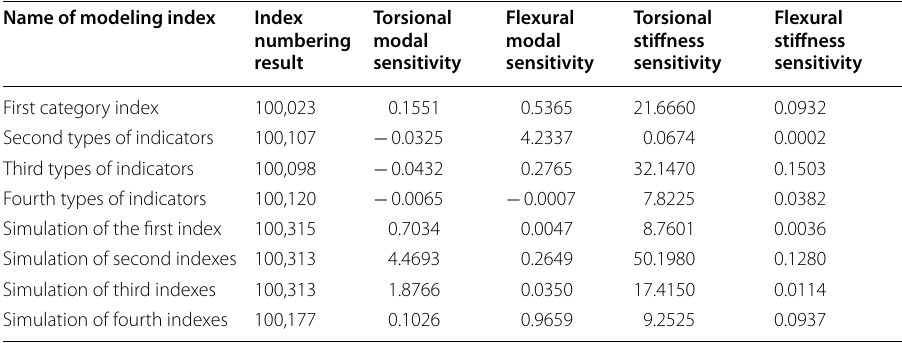
Table 2 Analysis results of index